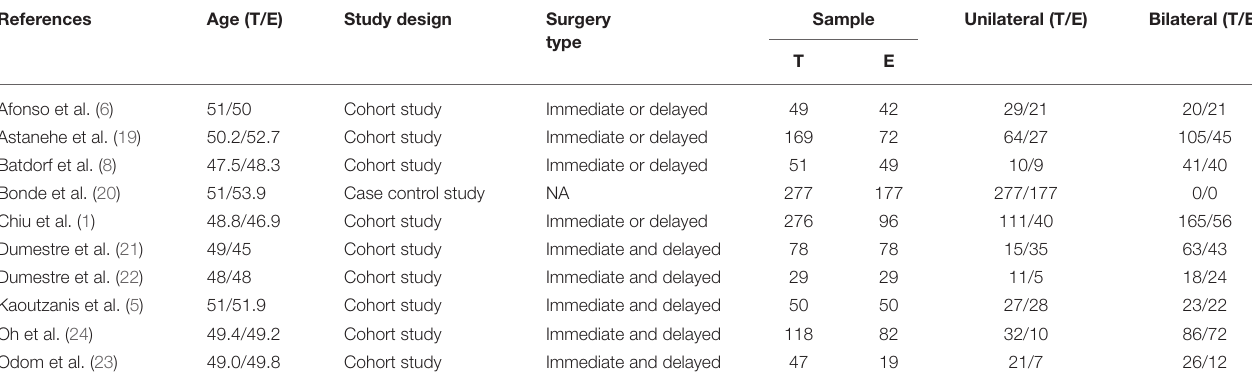
TABLE 1 | Patients’ and studies’ characteristics.